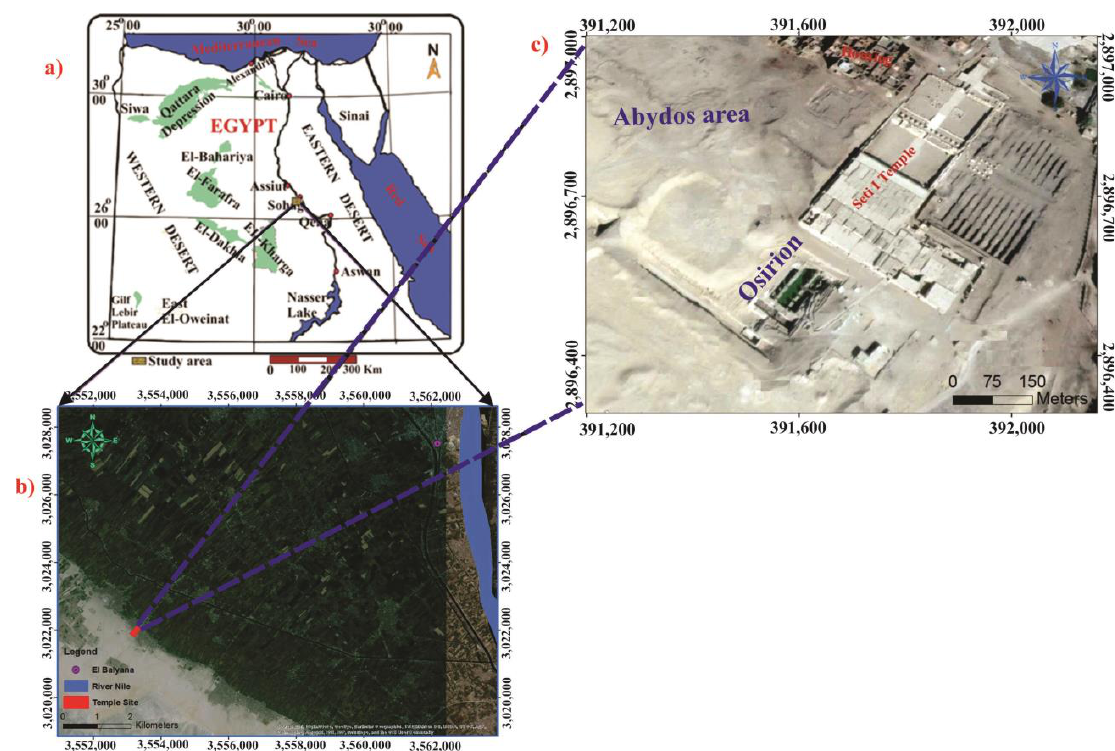
Figure 1. Location map of the Abydos archaeological site, El-Balyana city, Sohag, Egypt, where ( a ) the global map of Egypt, ( b ) a location of El-Balyana town, Sohag Governorate, Egypt which contains Abydos archeological site, and ( c ) a map of the Abydos site, which displays the nearby